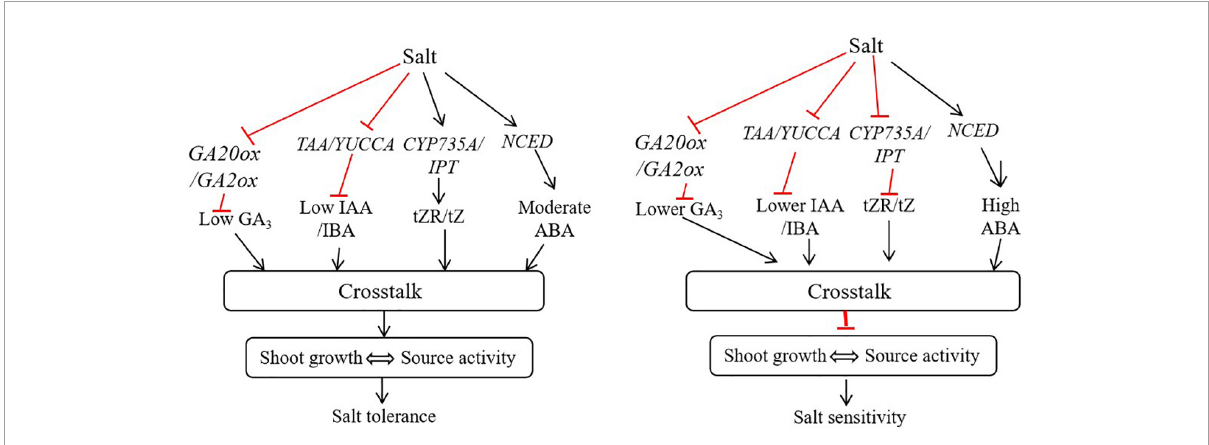
FIGURE10 A proposed working model of how hormonal reprogramming and crosstalk are involved in shoot growth and salt tolerance in bermudagrass. In shoots, salt stress induces the expression of CYP735A/IPT and NCED genes involved in tZR, tZ and ABA biosynthesis. The activation of these genes increases the accumulation of respective hormones in shoots. Subsequently, these hormones could work together through hormonal crosstalk and maintain shoot growth and source activity, ultimately improving salt tolerance in bermudagrass. In contrast, salt stress inhibits the expression of TAA/YUCC , CYP735A/IPT , and GA20ox/GA2ox genes, leading to reduced auxin, cytokinin and gibberellin levels in shoot, respectively. On the other hand, salt stress strongly induces the expression of NCED , leading to the accumulation of a high level of ABA in shoot. The reduced levels of auxin, gibberellin and cytokinin and high ABA level undergo hormonal crosstalk in shoot and inhibit shoot growth, thus diminishing source activity and increasing salt sensitivity in bermudagrass.